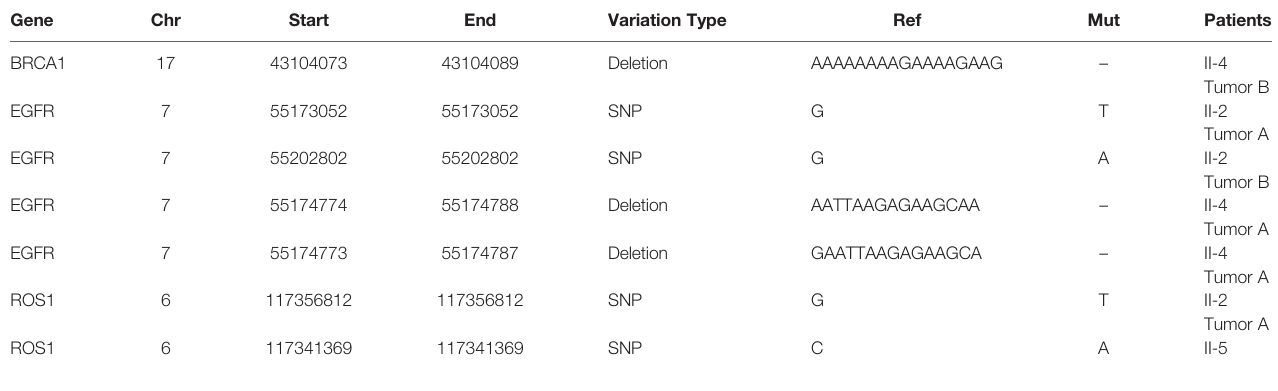
TABLE 2 | Known somatic mutation patterns in three